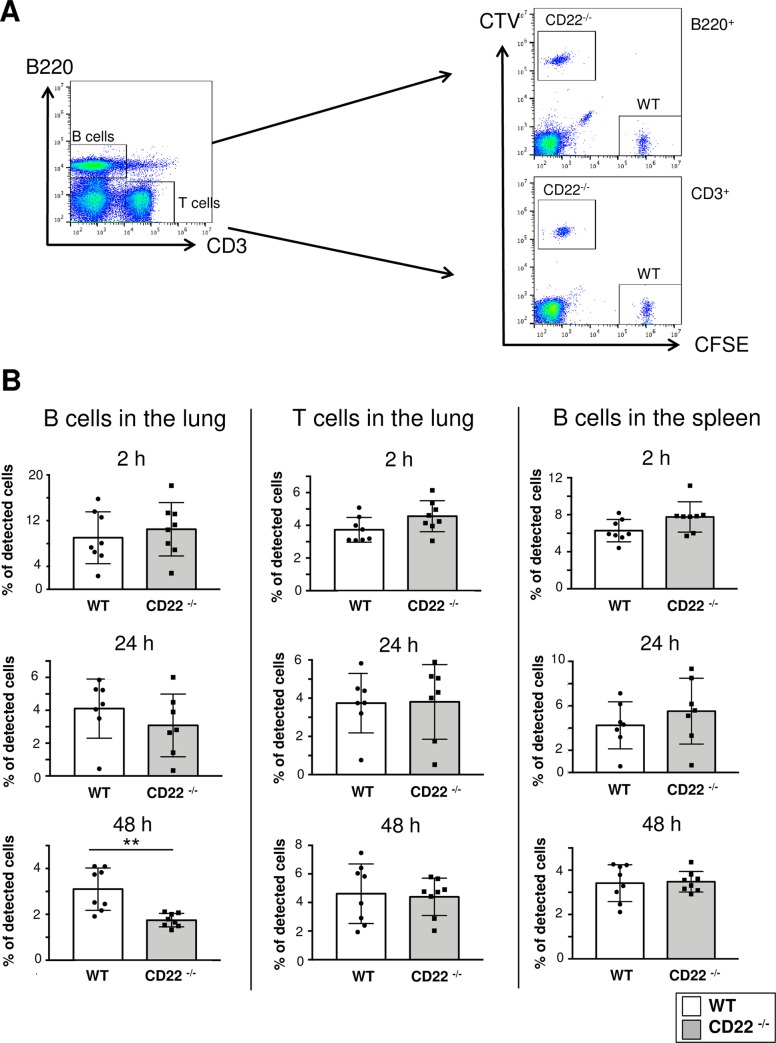
Reduced CD22-/- B cell numbers in the lungs of recipient mice detected 48 hours after cellular transfer.Flow cytometric analysis of lung and spleen cells from C57BL/6 mice injected i.v. with CFSE labelled C57BL/6 WT splenocytes and CTV labelled CD22-/- splenocytes (or vice versa) in a 1:1 mix. At various time points lungs and spleens were collected and stained for B220 and CD3. A) Gating strategy for the analysis of the proportion of WT and CD22-/- B and T cells found in the lung of recipient WT mice. B) Analysis of the percentage of WT and CD22-/- B and T cells found in the lung and spleen 2, 24 and 48 hours after i.v. injection. The proportion of WT and CD22-/- donor cells is displayed as the ratio of the percentage of CTV or CFSE-positive B or T cells found in the lung or spleen of recipient mice, divided by the percentage of CTV or CFSE-positive B or T cells injected (input) x 100. Bar diagrams show a summary of 11 independent experiments with 8 recipient mice per time point. Statistics were done with a two-tailed t test. ** = p<0.01.